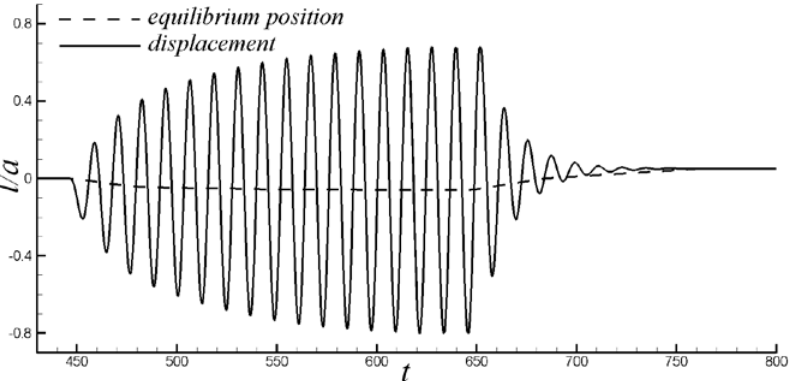
Figure 16. Evolution of the cylinder displacement before and after application of Lorentz force (upper surface N = 3, lower surface N = 2) in shear flow for K = 0.2.